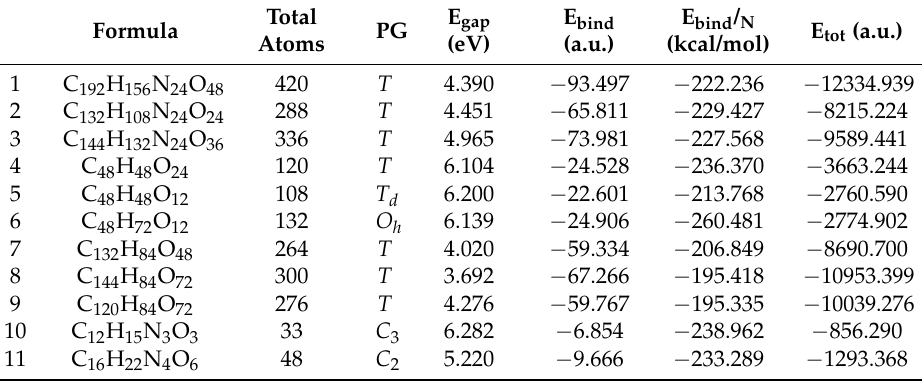
Table 2. Computational results obtained at the B3LYP/6-31G (d, p ) level of theory using the Gaussian 09 suite [28]: the point group symmetry (PG), HOMO-LUMO energy gap (E gap ), binding energy (E bind ), binding energy per number of heavy atoms (E bind/N ), and the total energy (E tot ).